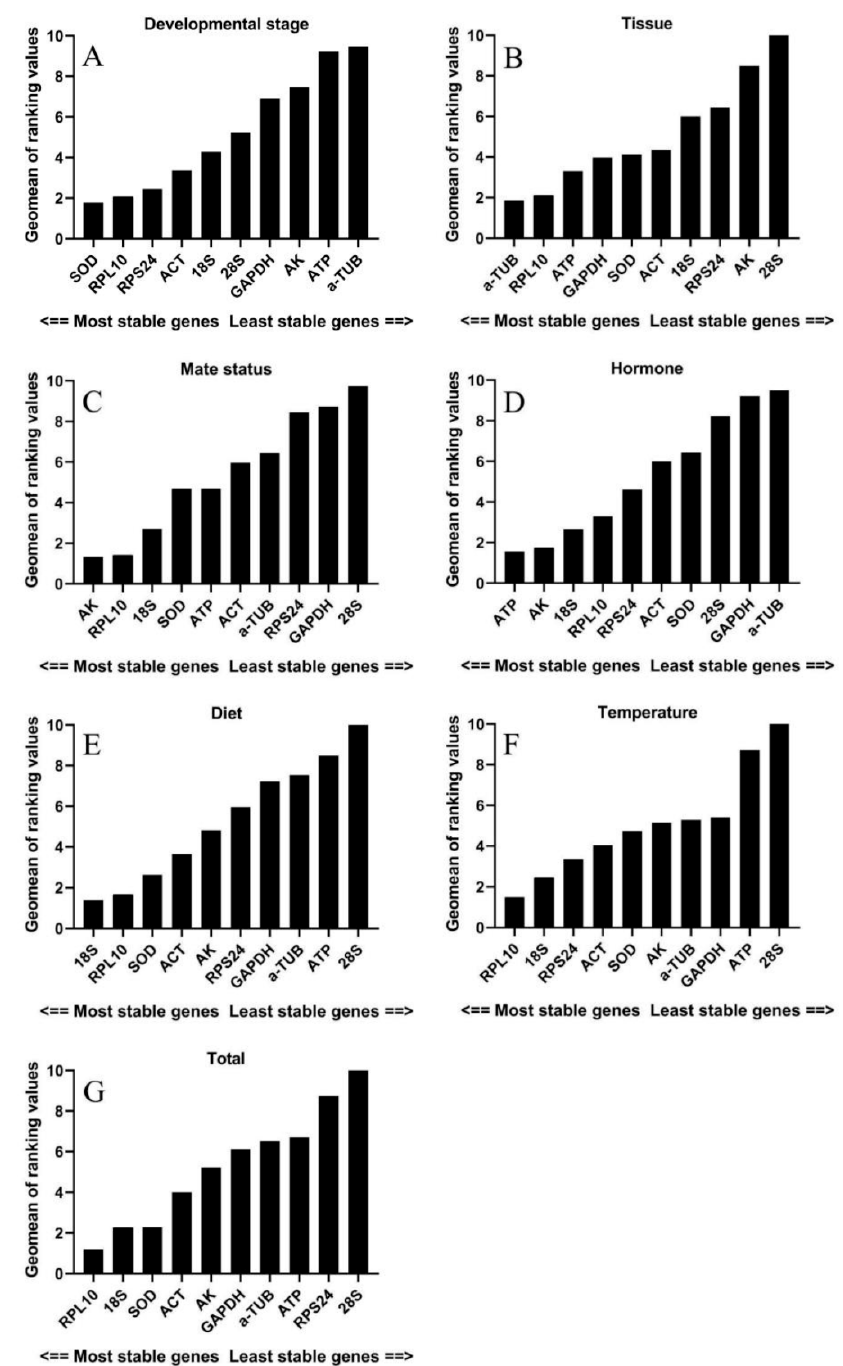
Figure 2. Expression stability of 10 candidate reference genes of S. frugiperda in different treatments by RefFinder. A lower Geomean value indicates more stable expression. ( A ) different developmen- tal stages; ( B ) various tissues; ( C ) mating status; ( D ) hormone treatment; ( E ) diets treatment; ( F ) temperature treatment; ( G ) all samples.